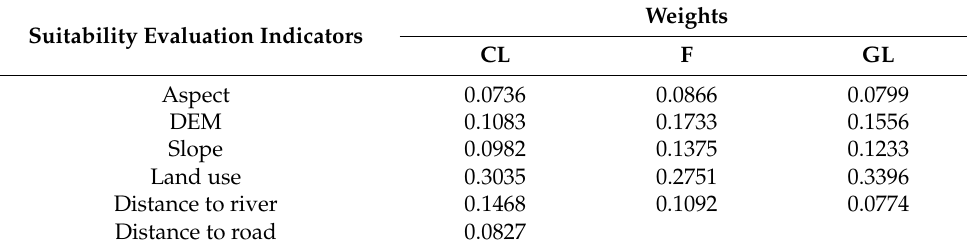
Table 6. Weights of land use suitability evaluation